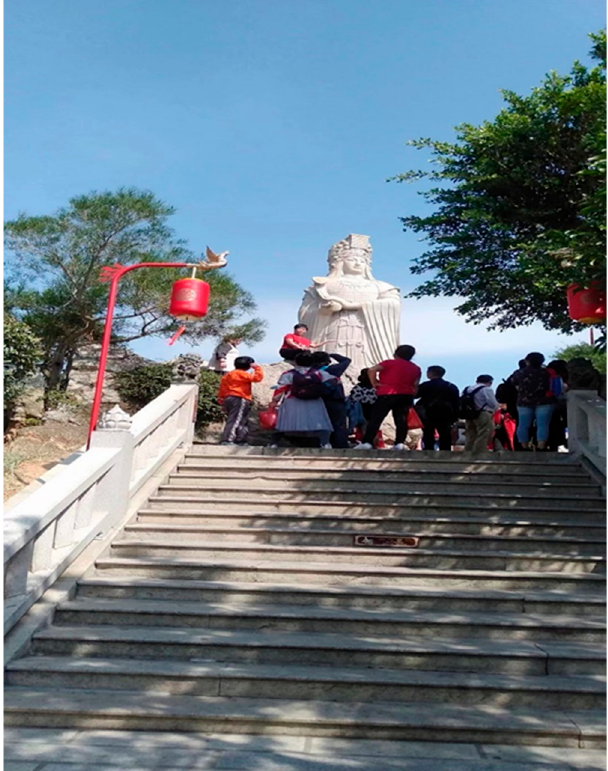
Figure 1. The statue named “the Goddess of Peace.” Source: Author’s photograph.